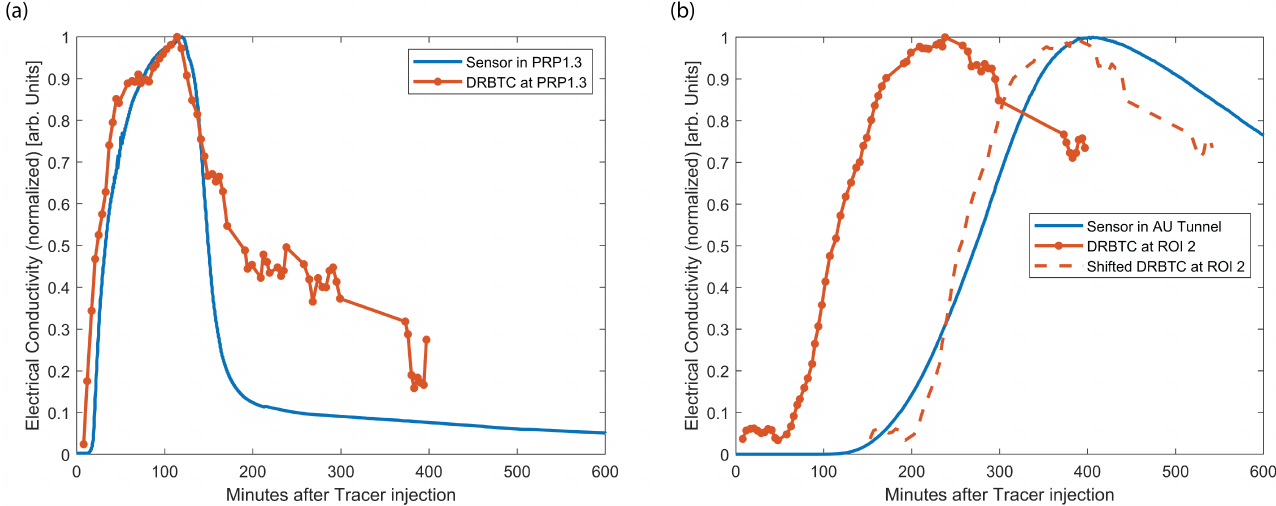
Figure 8. Comparison of the DRBTC and sensor BTC during Experiment 2. ( a ) Shows the data for the PRP1.3 interval and the accordingly defined ROI. ( b ) Shows the DRBTC for ROI 2 and the sensor BTC for the AU tunnel outflow. Additionally, the DRBTC for ROI 2 has been shifted to the extrapolated arrival time at the AU tunnel from the velocity field of Experiment 2 in Section